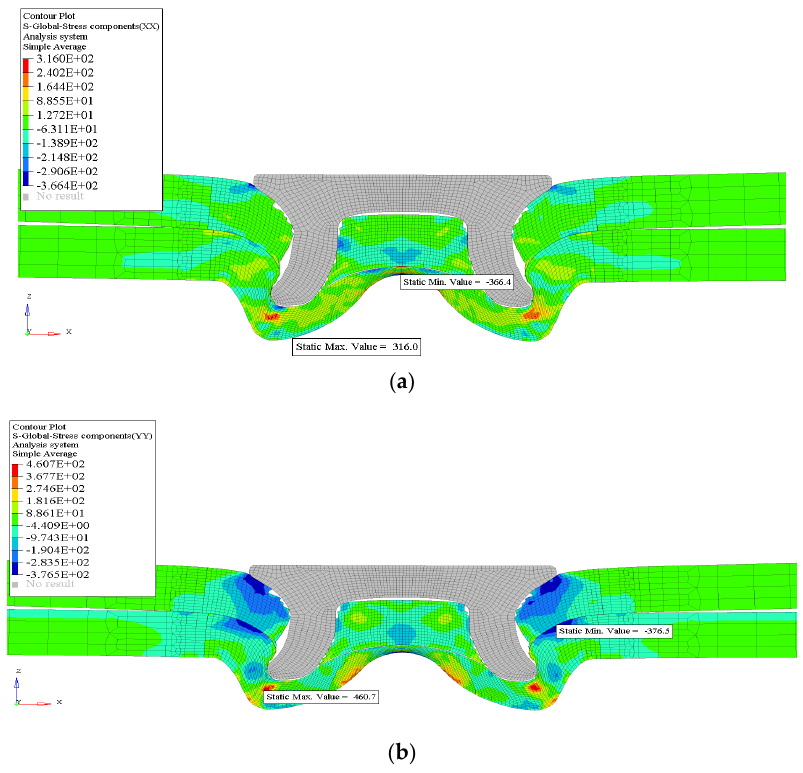
Figure 9. Residual stress ( a ) σ r and ( b ) σ θ distributions for the SPR joint after spring-back.